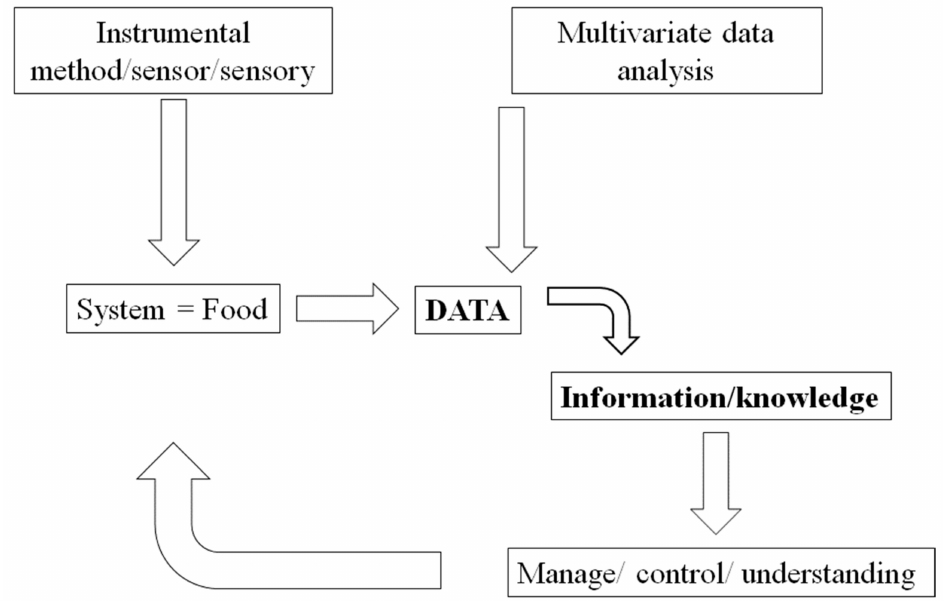
Figure 1. A schematic representation of the application of multivariate data analysis in the food